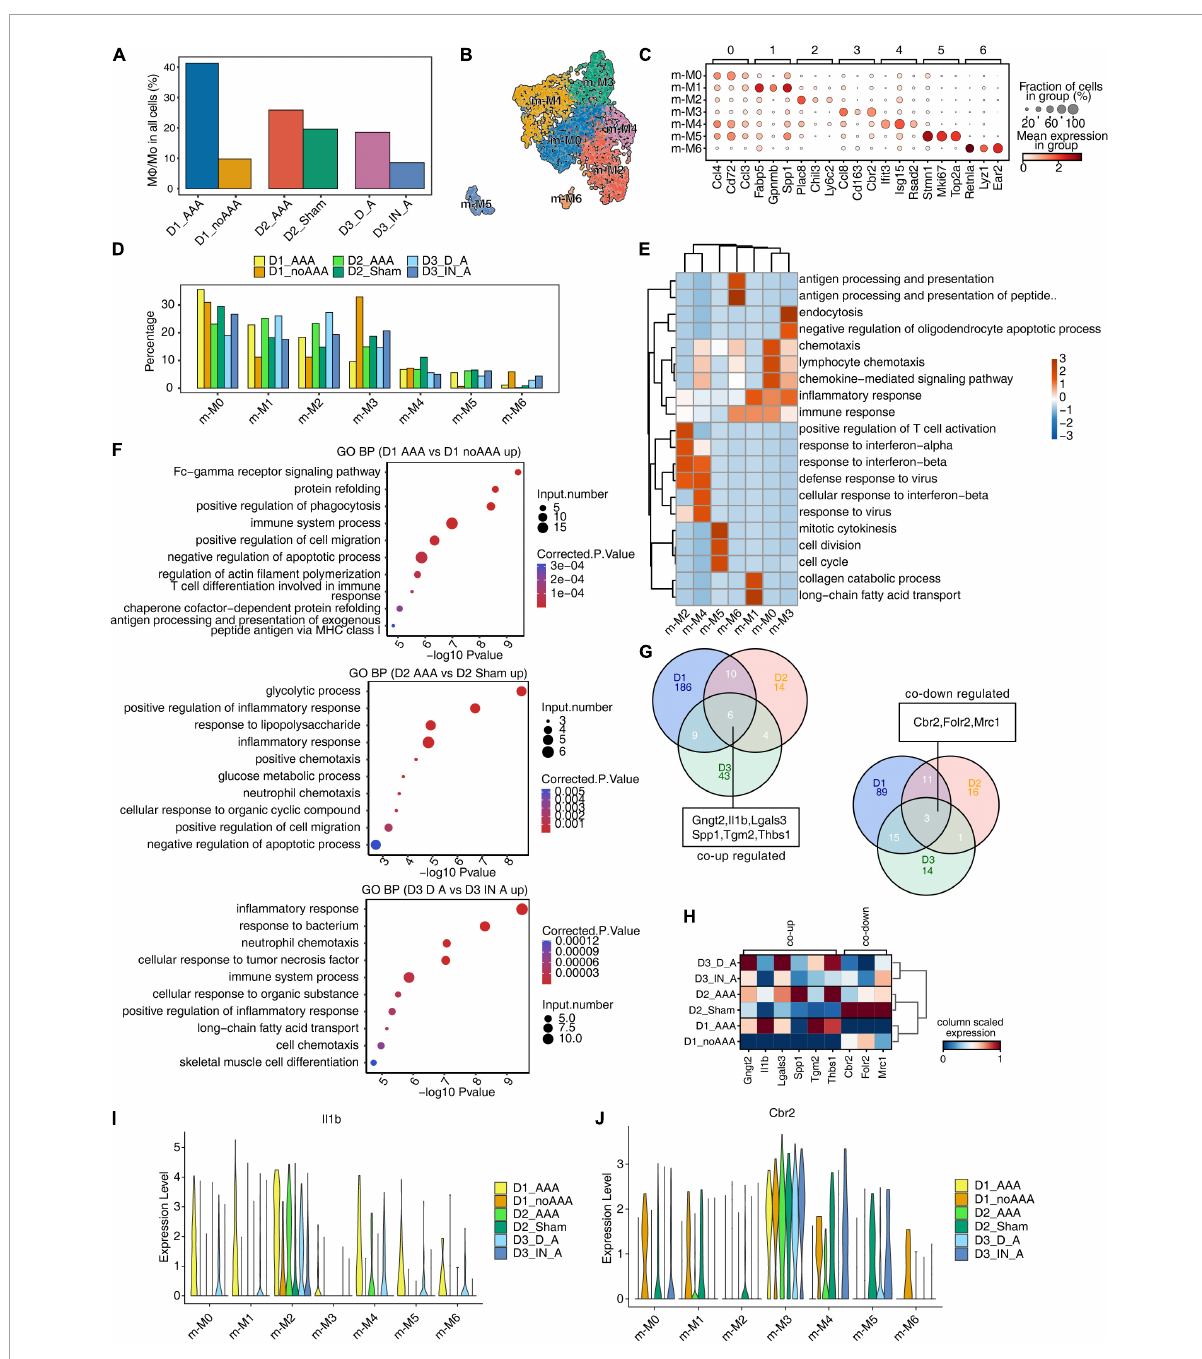
FIGURE2 Single-cell analysis revealed complex macrophages/monocytes (M ϕ /Mo) heterogeneity and conserved regulated genes between abdominal aortic aneurysm (AAA) and control samples. (A) Barplot represented the percentage of M ϕ /Mo in total cells. (B) Uniform manifold approximation and projection (UMAP) plot of single-cell RNA sequencing (scRNA-seq) profile from M ϕ /Mo separated into seven subtypes. Cells were colored according to different cell types. (C) Dot plot showing expression of top 3 markers in each subtype of M ϕ /Mo. Color of dots represented the log fold change in each cluster comparing with other cells and dot size indicated percentage of cells in each cluster expressing the marker genes. (D) Bar plot comparing the proportions of cell populations of subtype of M ϕ /Mo within each sample group. (E) Gene ontology enrichment analysis of biological processes of marker genes of each cell type. Top 3 terms were selected for each cluster and heatmap showed the enrichment q -value of these terms (scaled by column). (F) Gene ontology terms enriched in AAA versus in control M ϕ /Mo for each dataset, respectively. The top 10 terms from upregulated genes are depicted as scatter plots displaying –log 10 ( p -value) and gene number. (G) Venn diagram showing the co-up (left) and co-down (right) regulated genes comparing AAA M ϕ /Mo with control group from three datasets. (H) Unsupervised clustering heatmap showing relative expression (column scaled) levels of co-up genes and co-down genes in M ϕ /Mo of each sample group. (I,J) Gene expression level of Il-1b (I) and Cbr2 (J) were represented in the violin plot split by different sample